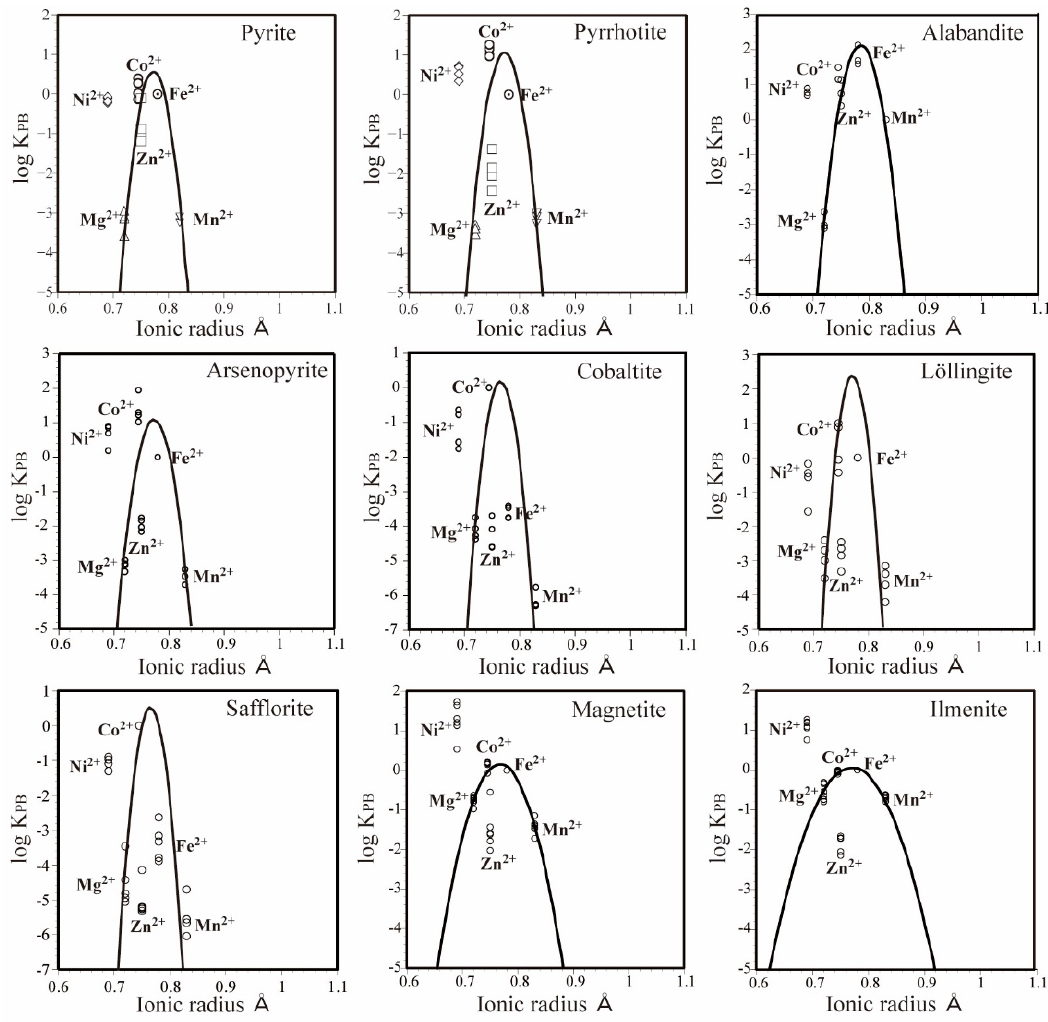
Figure 5. PC-IR diagrams at 600 °C and 100 MPa for pyrite [2], pyrrhotite [2], alabandite [this study], arsenopyrite [3], cobaltite [3], löllingite [4], safflorite [4], magnetite [16], and ilmenite [17].